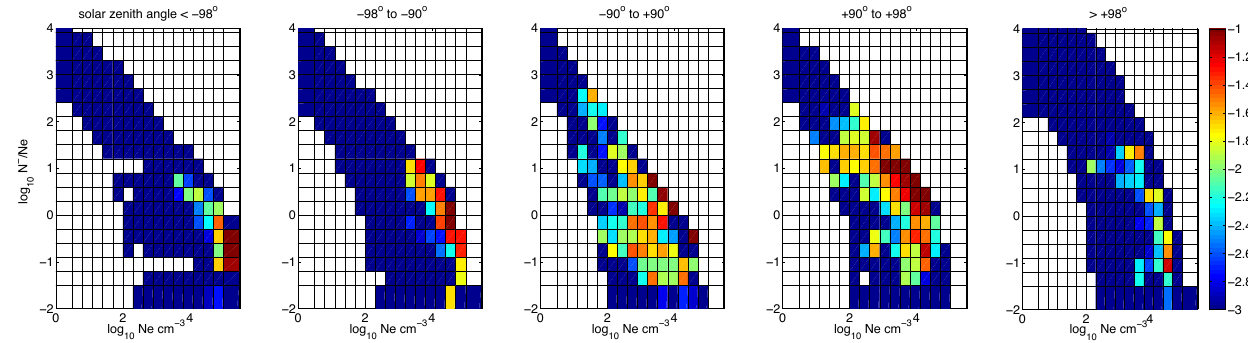
Figure 9. PMWE detection rates at heights of 50–80km, as a function of modelled electron density and modelled ratio of negative ion to electron density: (first panel) morning darkness, (second panel) morning twilight, (third panel) daylight, (fourth panel) evening twilight, and (fifth panel) evening darkness. Colour scale is log 10 of the PMWE detection rate. White areas indicate conditions not present at any time during the modelled events.